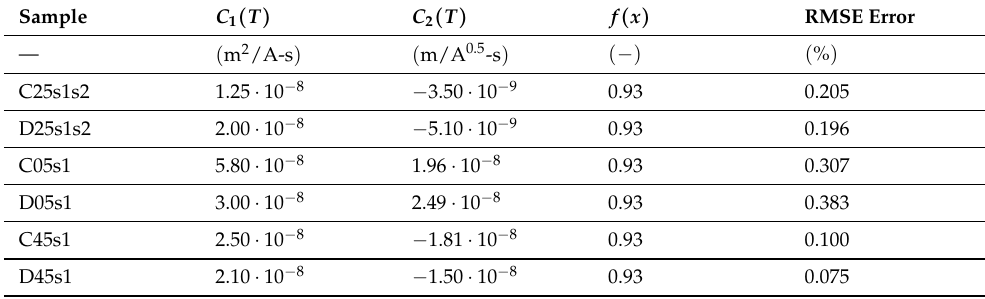
Table 9. First adjustment of the parameters C 1 ( T ) and C 2 ( T ) to fit the experimental data at tempera- tures 25, 5 and 45 ◦ C.